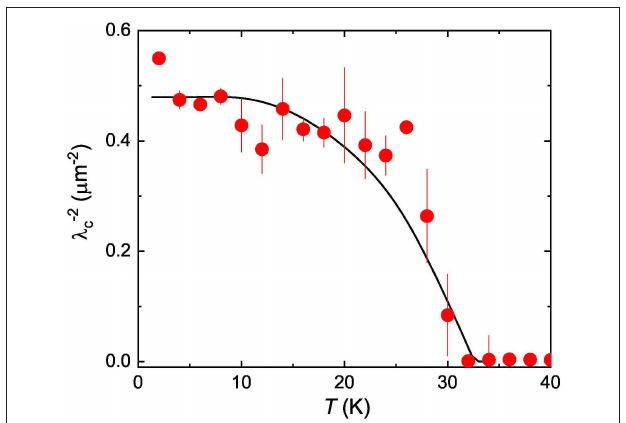
FIGURE 7 | Temperature evolution of the inverse squared out of plane magnetic penetration depth λ − 2 c ( T ). The solid line is obtained from the theoretical λ − 2 ab ( T ) and λ − 2 ab , c ( T ) curves, as they presented in Figure 5 , by using Equation (13).